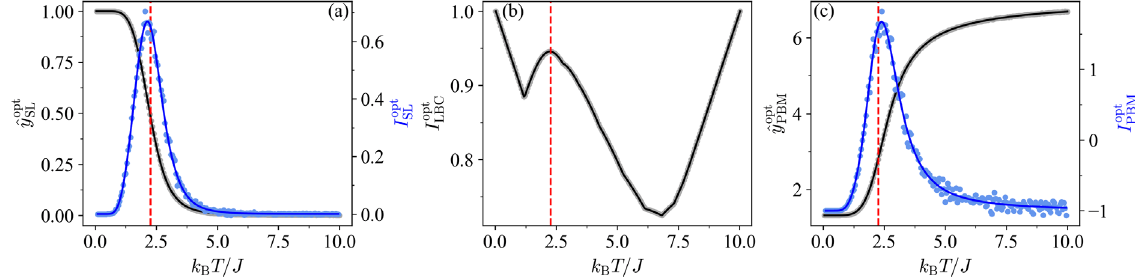
T=J , where p 1 ¼ 0 . 05 , FIG. 9. Results for the Ising model ( L ¼ 4 ) with the dimensionless temperature as a tuning parameter p ¼ k B 10 , and Δ p ¼ 0 . 05 . The critical temperature [Eq. (31)] is highlighted by a red dashed line. In SL, the data obtained at p p 1 and p K K ¼ 1 and l K . The inputs are computed based on spin configurations obtained through exact constitute our training set, i.e., r I ¼ II ¼ in SL (black line) and the corresponding enumeration (lines) or Monte Carlo sampling (points). (a) Mean optimal prediction ˆ y opt SL indicator I opt (blue line). (b) Optimal indicator of LBC, I opt (black line). (c) Mean optimal prediction ˆ y opt in PBM (black line) and the PBM SL LBC (blue line). corresponding indicator I opt PBM